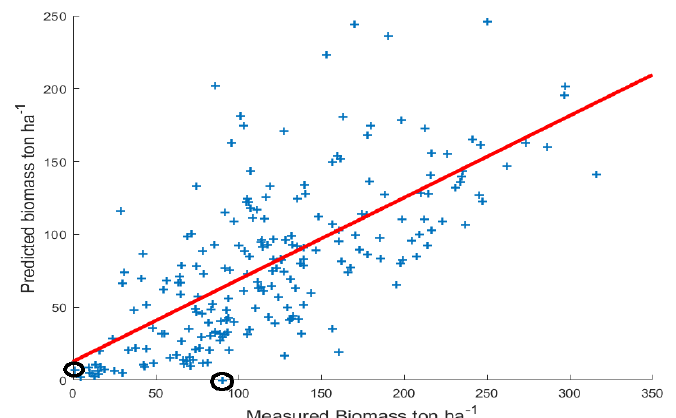
Figure 6. Relation between measured and predicted biomass using Lidar data with R 2 = 0.60 and RMSE = 0.68 ton ha − 1 . The points marked with dark circles are possibly the measurement errors. The plot shows a positive correlation between measured biomass and predicted biomass by Lidar height. Two points marked with circles are most likely measurement errors.